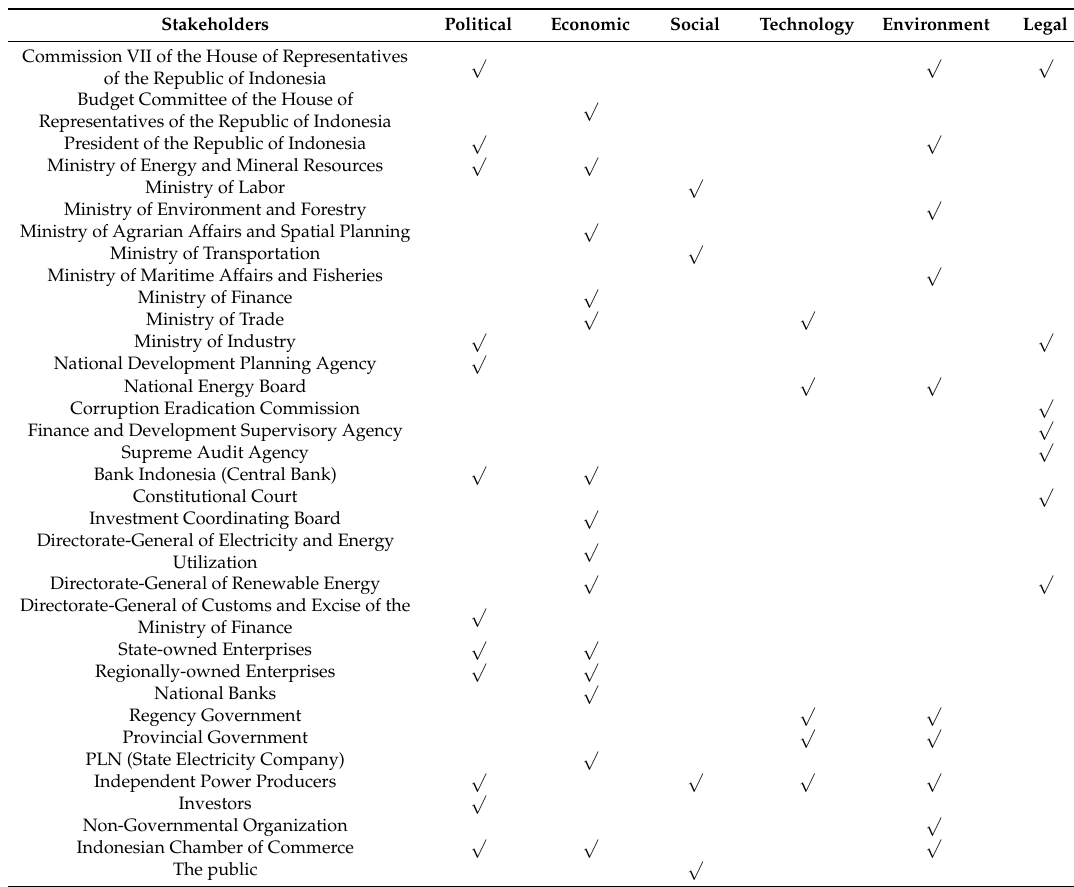
Table 2. Stakeholders of the renewable energy industry in